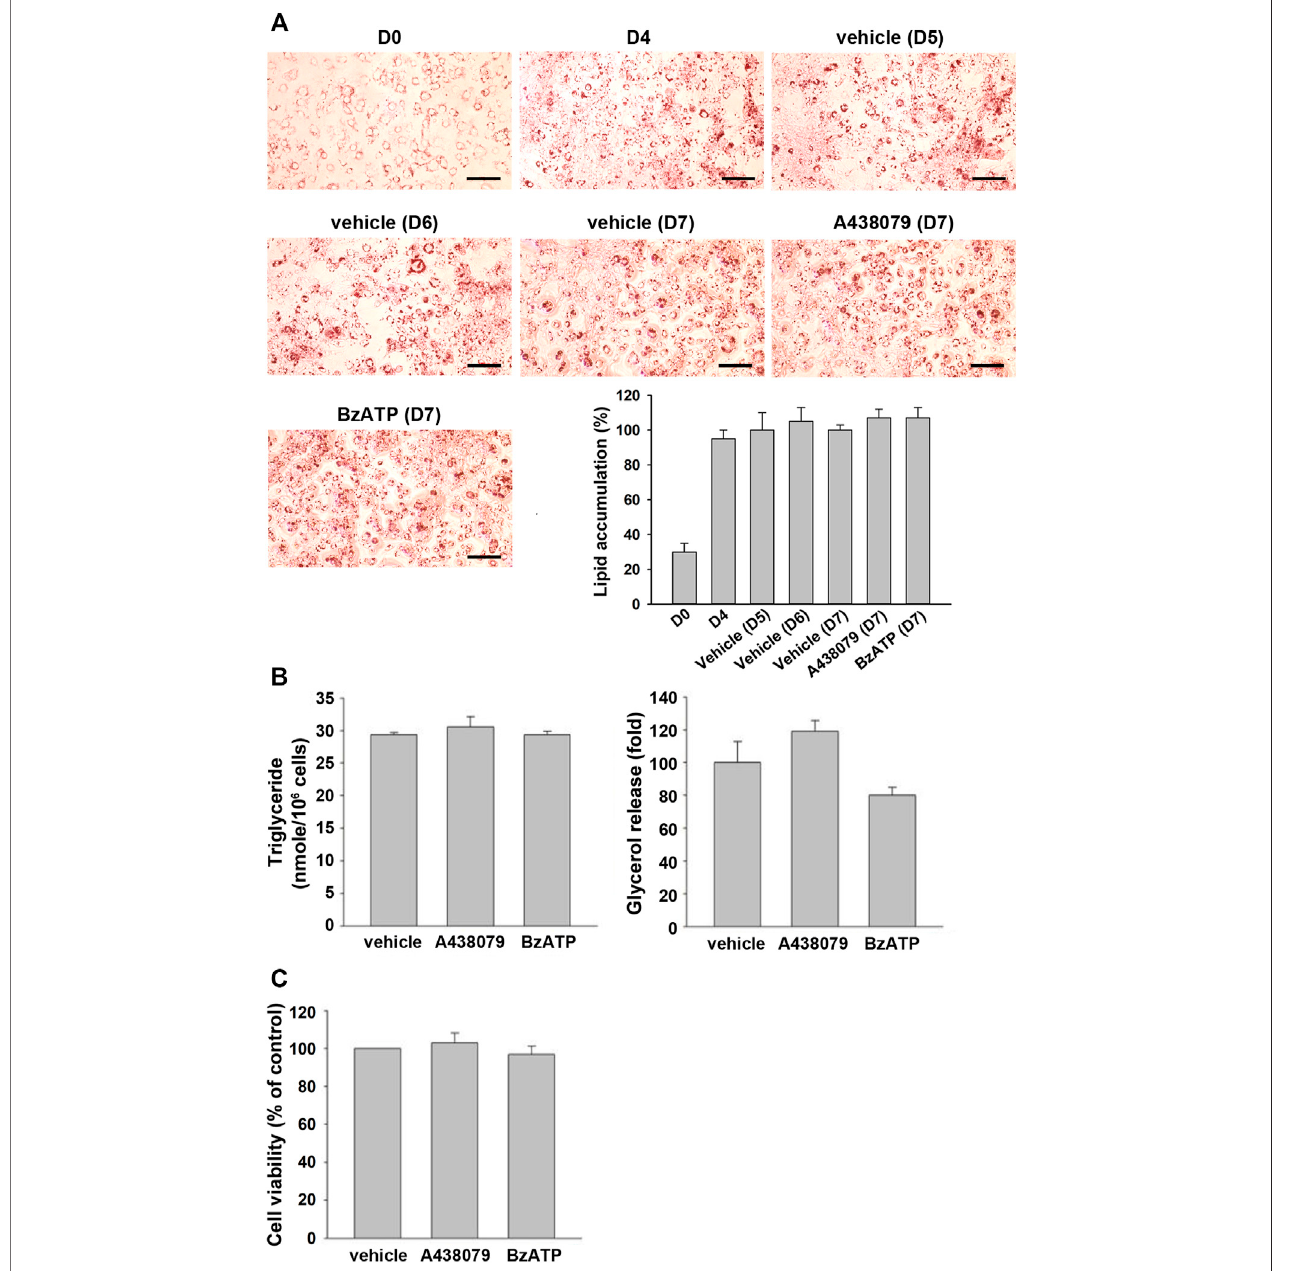
FIGURE4 | P2X7 does notaffectlipid metabolism ofadipocytes after four-day differentiation. Aftertwo-stage differentiation, 3T3-L1 adipocytes wereculturedin a completeDMEMcontaining10%FBSwithoutinsulin,butwithA438079(10 μ M)orBzATP(50 μ M)foradditionalthreedays. (A) Cellsatindicateddifferentiationdaywere stainedwithOilRedOandquanti fi edtodeterminelipidaccumulation. (B) IntracellulartriglyceridelevelandglycerolreleaseatD7weredetermined. (C) Thecellviabilityof differentiated adipocytes at D7 was measured by Trypan Blue cell counting. Data are presented as mean ± SEM from at least three independent experiments.